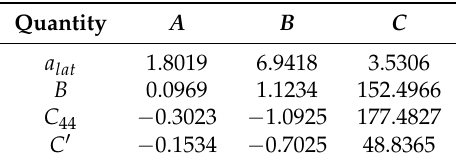
Table A3. Fit parameters A , B and C for the lattice constants ( a lat ), the bulk modulus ( B ), the elastic constants C 44 (in GPa) and C (cid:48) (in GPa) as they appear in Equation